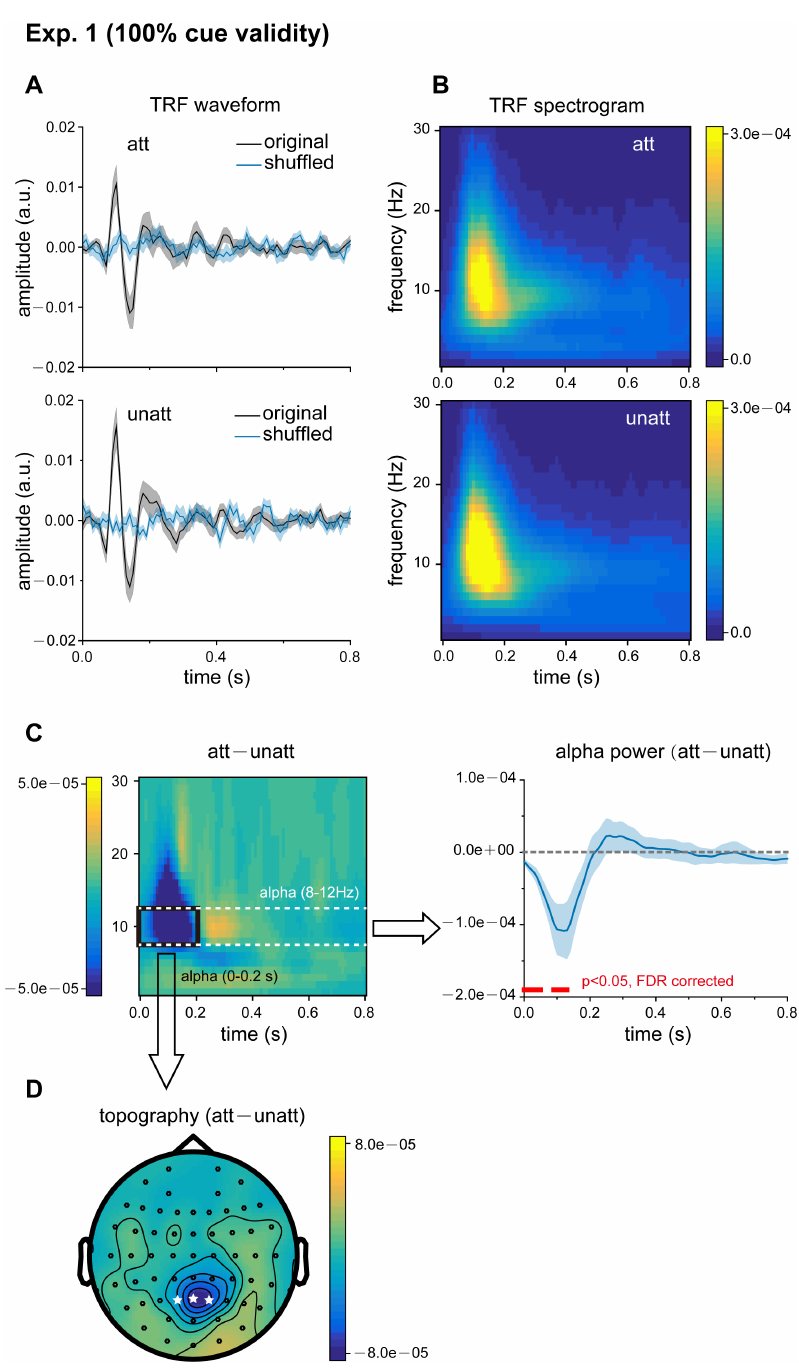
Fig 2. Results for Experiment 1 (100% cue validity): attentional alpha inhibition in temporal response functions (TRFs). (A) Grand average( N = 18) TRF waveforms for attended(top panel, black lines, mean ± SEM) and unattended (bottom panel, black lines, mean ± SEM) visual sequencesas a function of latency (0–0.8 s), representingbrain responses to each unit increase in luminance in the visual stimulus sequence. Blue lines represent the TRFs obtained after the stimulus sequencesand electroencephalography (EEG) responses were shuffled. (B) Grand average( N = 18) time–frequency power profile for attended(att; top) and unattended (unatt; bottom) TRFs as a function of latency (0–0.8 s) and frequency(0–30 Hz). (C) Left: grand average( N = 18) time–frequency plots for att − unatt TRF power difference. Right: grand average(blue lines, mean ± SEM) time course for att − unatt TRF power within the alpha band(8–12 Hz). Red horizontal lines